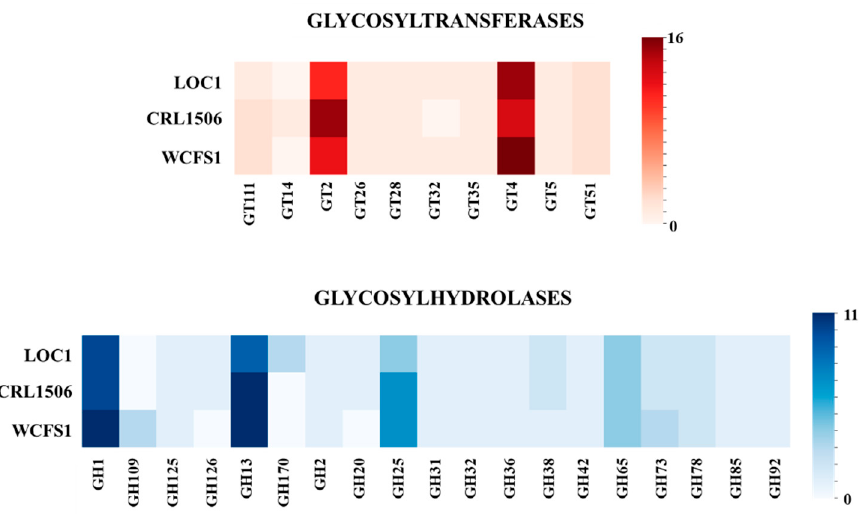
Figure 8. Analysis of the number of genes of the different families of glycosyltransferases (GT) and glycosylhydrolases (GH) in Lactiplantibacillus plantarum LOC1. The genome of the LOC1 strain was studied and compared with the probiotic strains WCFS1 and CRL1506 as reference.